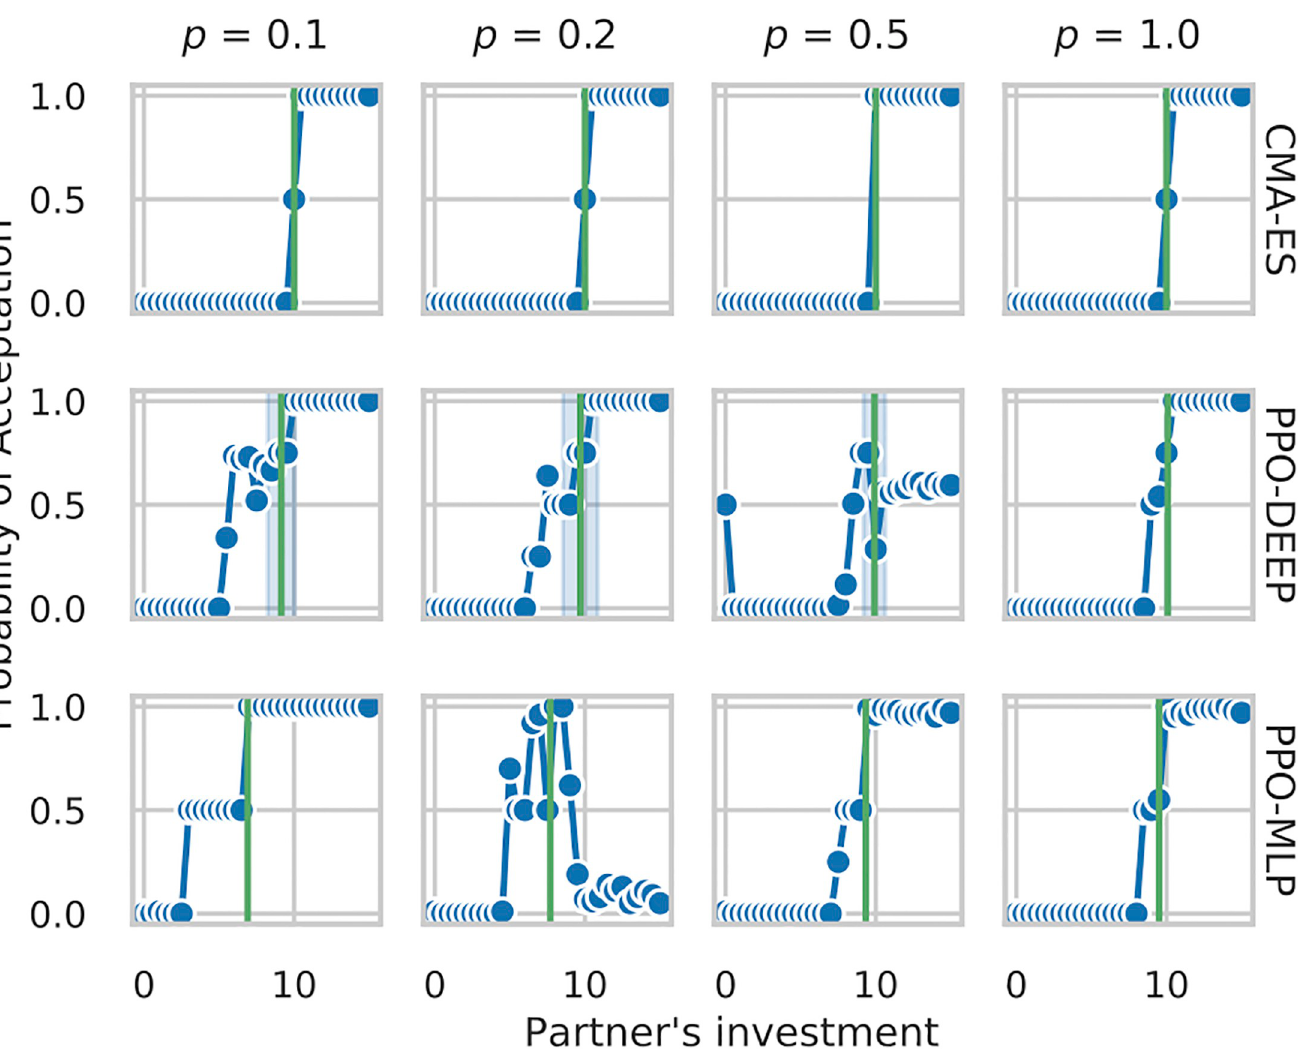
Fig 7. Analysis of the Partner Choice module for all conditions (by columns: p 2 {0.1, 0.2, 0.5, 1.0}) and all algorithms (top: CMAES, center: PPO-DEEP, bottom: PPO-MLP). For each setup, only the best policy is shown. Each graph plots the probability to accept cooperation for the focal agent following the best policy (y-axis) depending on its partner’s proposed investment (x-axis). Data are computed by presenting each of the 31 possible cooperative partners to the focal agent for 100 iterations as policies are stochastic. The green vertical line represent the mean investment of the focal agent.